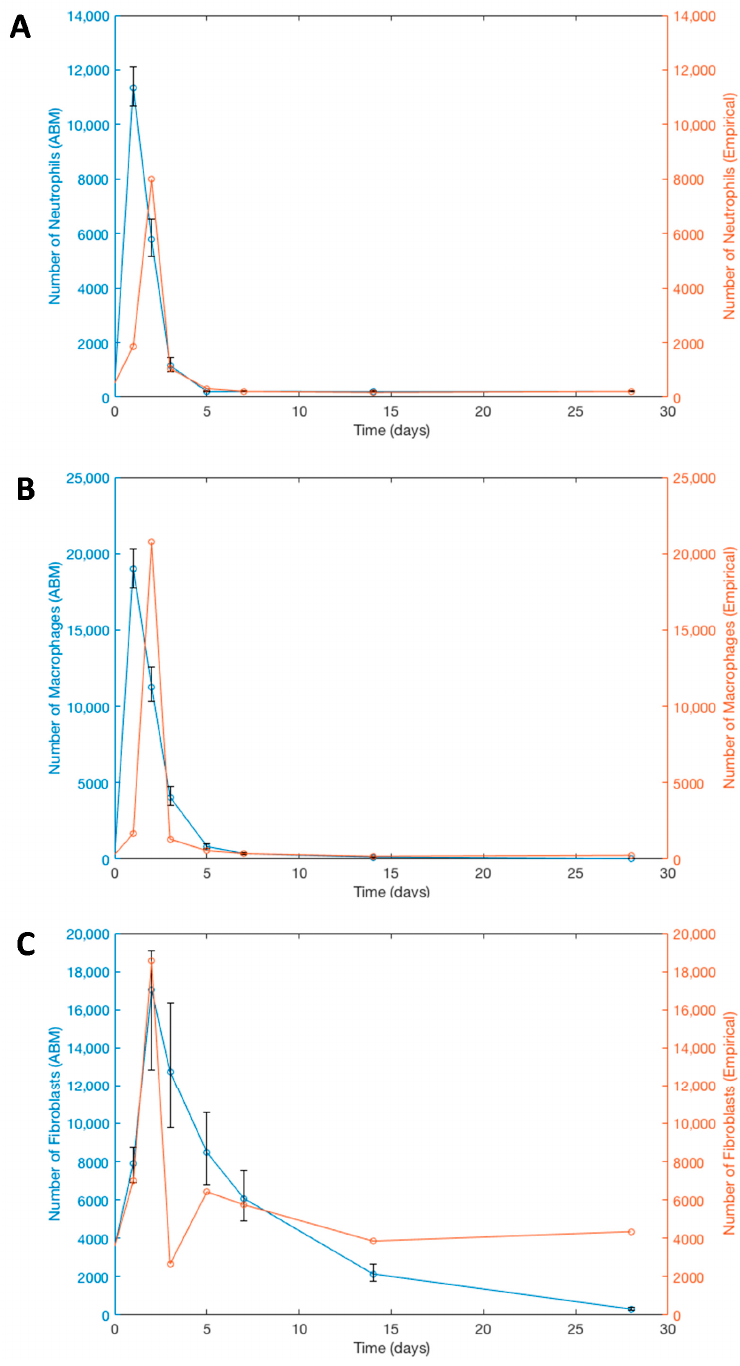
Figure 4. Empirical and ABM-simulated trajectories of cell populations in injured vocal